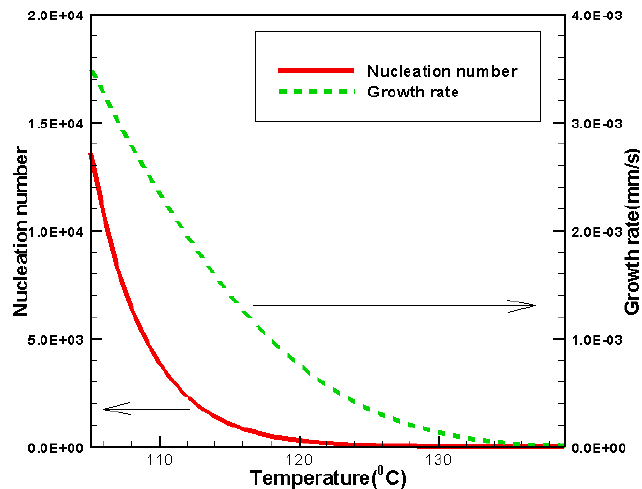
Figure 3. Nucleation number and growth rate for isotactic polypropylene (iPP) over the temperature range 105–140°C